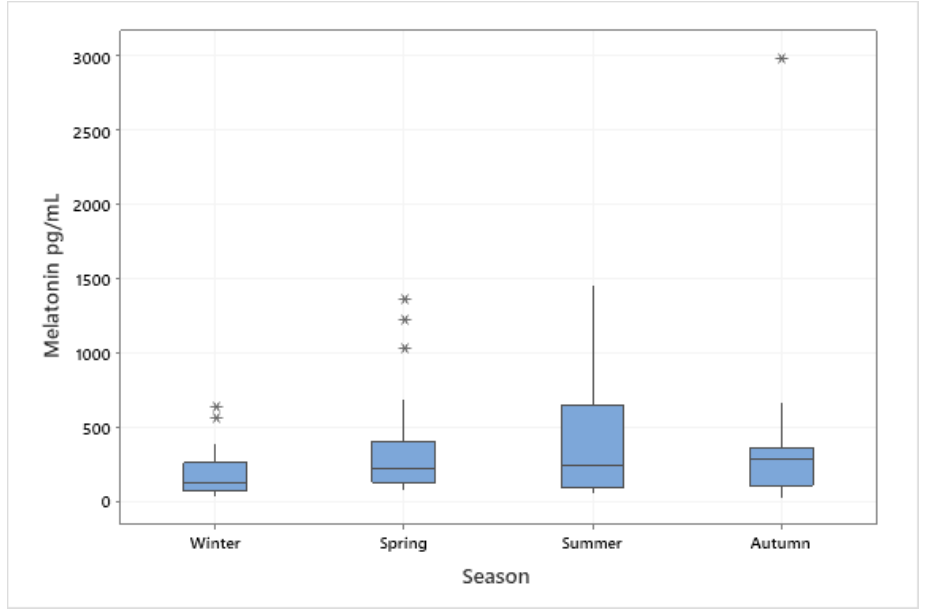
Figure 2. Boxplot of serum melatonin in different seasons. There were n = 9 bitches and 121 obser- vations. There were no significant differences between seasons ( p > 0.05). * represent outliers.